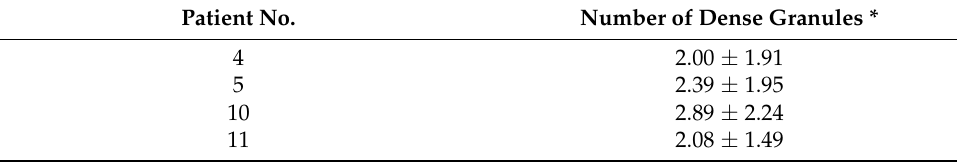
Figure 2. Representative pictures of dense granules (arrows in A – C ) in platelets: ( A ) normal; ( B ) patient 10; ( C ) patient 11. Images were obtained using transmission electron microscopy (TEM; JEM-1010, JEOL, Peabody, MA, USA). Bar scale is 2 µm. Table 4. Results of TEM.